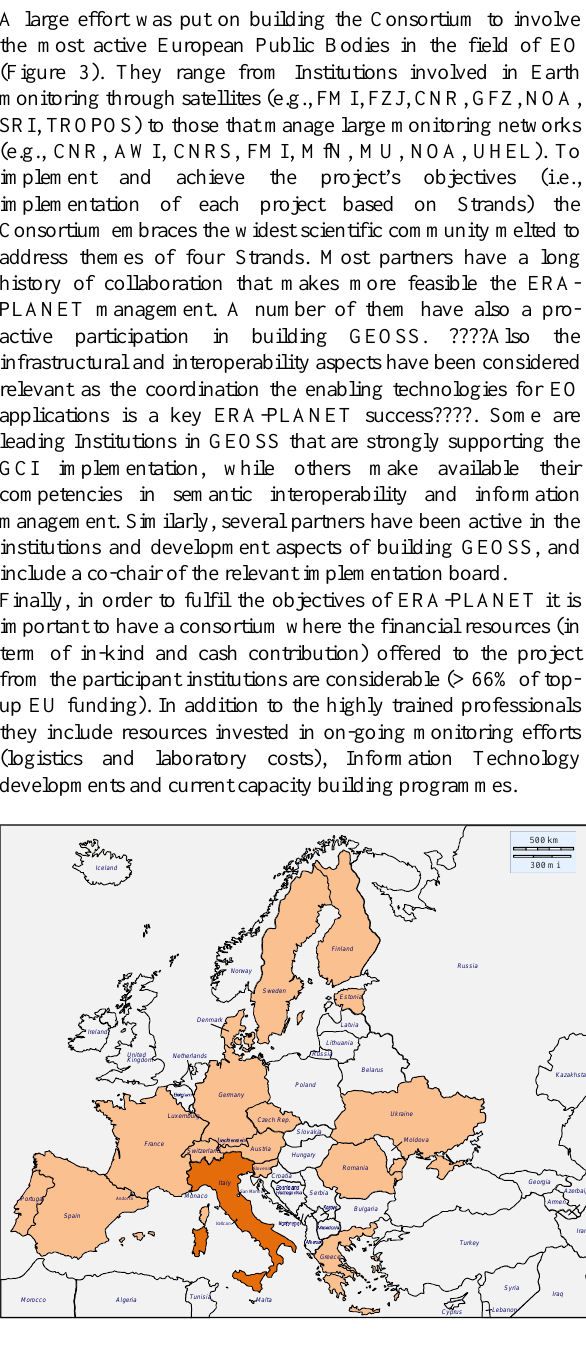
Figure 3. Countries participating to